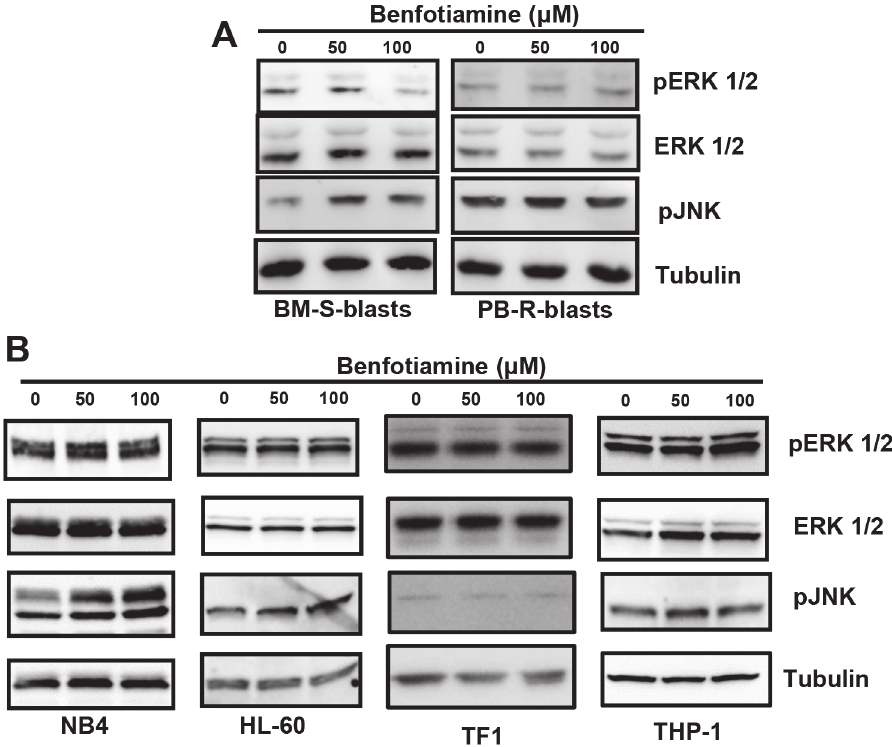
Fig 3. Modulation of MAPK members by benfotiamine. BM-S-blasts or PB-R-blasts (A) and HL-60, NB4, THP-1 and TF1 cells (B) were cultured for 24 hours with the indicated doses of benfotiamine and analyzed for phosphorylated ERK 1/2 and JNK1/2 via Western blotting. Representative results of three independent experiments are